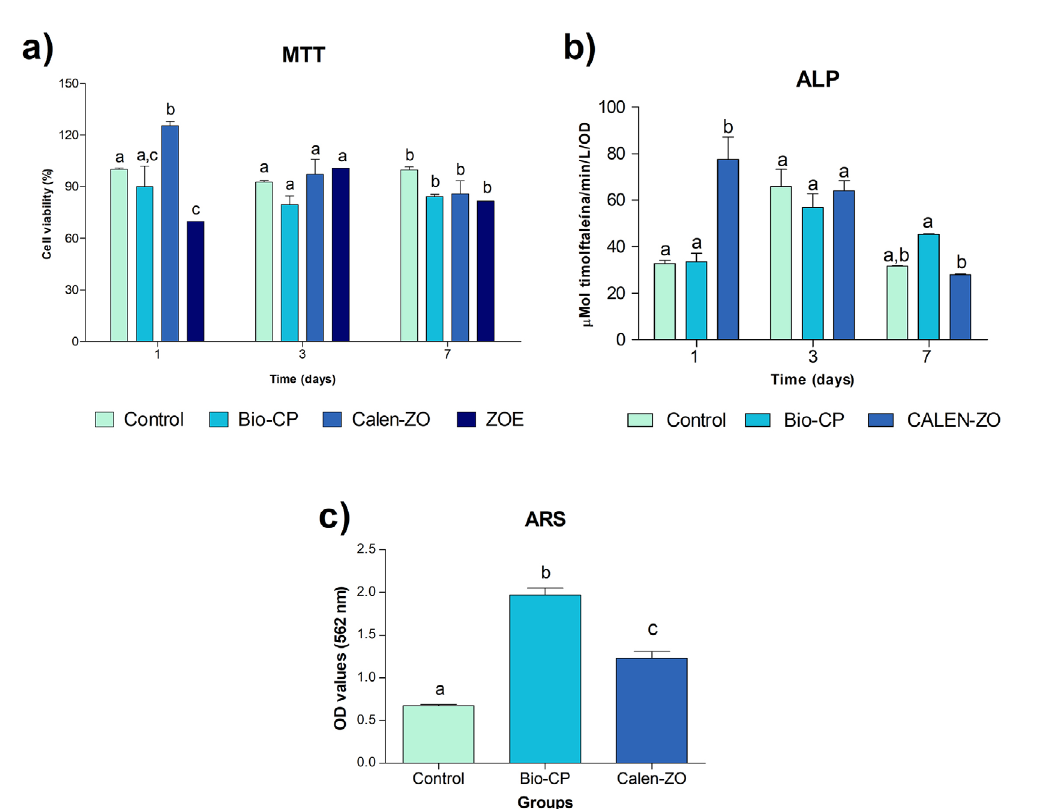
Figure 3- Effect of root canal filling materials (1:24 dilution) of primary teeth on the biology of Saos-2. MTT assay (a) and alkaline phosphatase (ALP) activity (b) were performed 1, 3 and 7 days after exposure of Soas-2 to extracts of materials and serum-free culture medium (control), whereas alizarin red stain (ARS ) assay (c) was evaluated after 21 days of cell exposure to material extracts and osteogenic culture medium (control). Bio-CP=Bio C Pulpecto; Calen-ZO=Calen mixed with zinc oxide and eugenol; ZOE=Zinc oxide and eugenol. Different letters indicate statistically significant differences among the materials